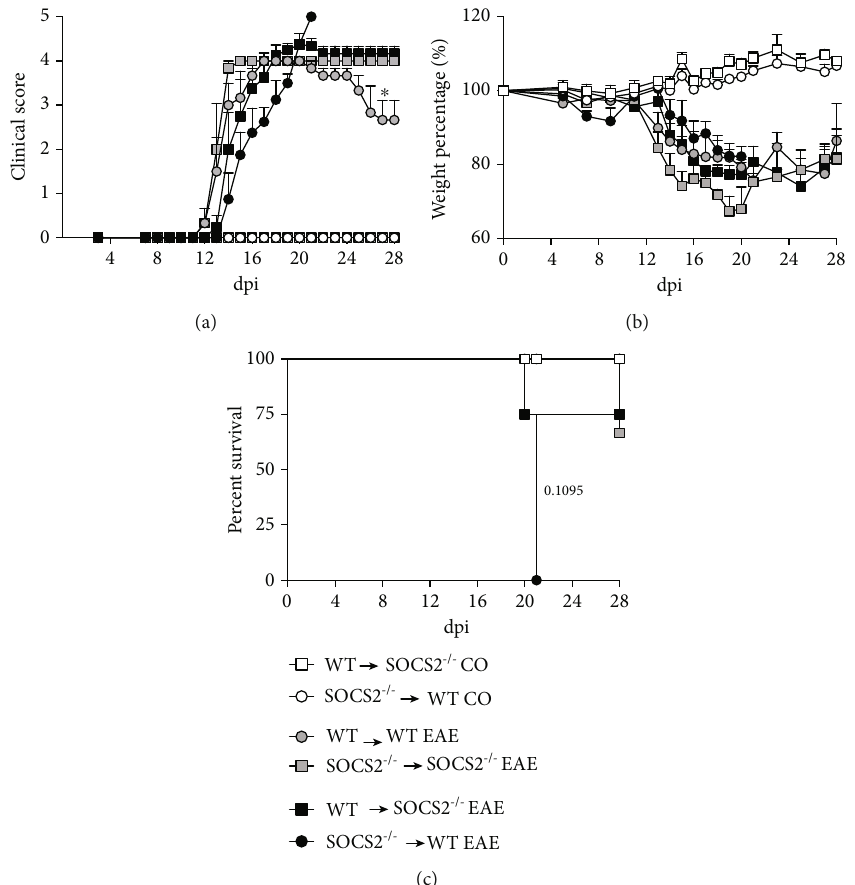
Figure 5: Role of SOCS2 in the hematopoietic and nonhematopoietic compartments in EAE development. EAE was induced in chimeric SOCS2 -/-donor → WT EAE host , WT donor → SOCS2 -/- EAE host , WT donor → WT EAE host , and SOCS2 -/-donor → SOCS2 -/- EAE host . (a) Score was monitored by clinical signs comparing WT with SOCS2 -/- mice. (b) Weight loss percentage and (c) survival were also assessed daily comparing WT with SOCS2 -/- animals. Data represent the mean ± SEM (statistical signi fi cance was performed by one-way ANOVA, with Tukey posttest and survival log rank